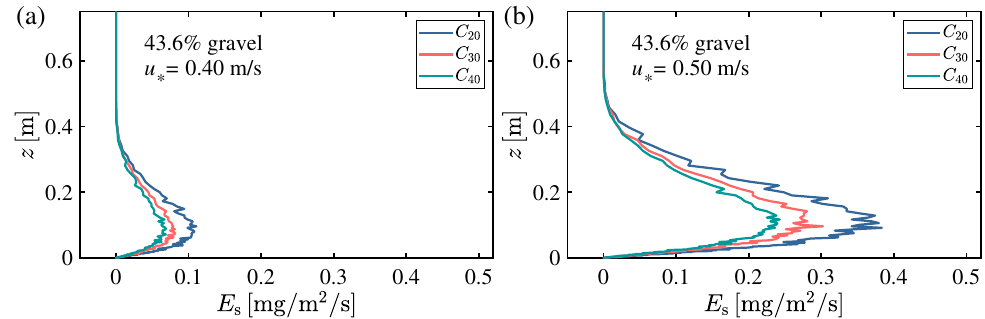
Figure 8. Vertical profiles of saltation erosion rate E s , corresponding to three types of concrete walls C 20 , C 30 and C 40 in Gobi with 43.6% gravel coverage, for ( a ) at u ∗ = 0.4m/s and ( b ) at u ∗ =